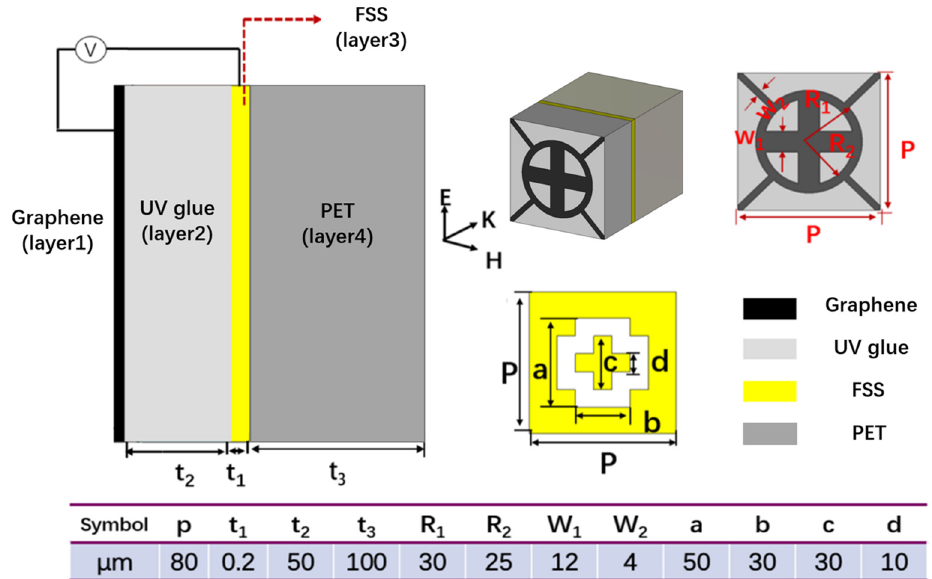
Figure 2. Structure and size of the graphene-based tunable metamaterial unit cell.